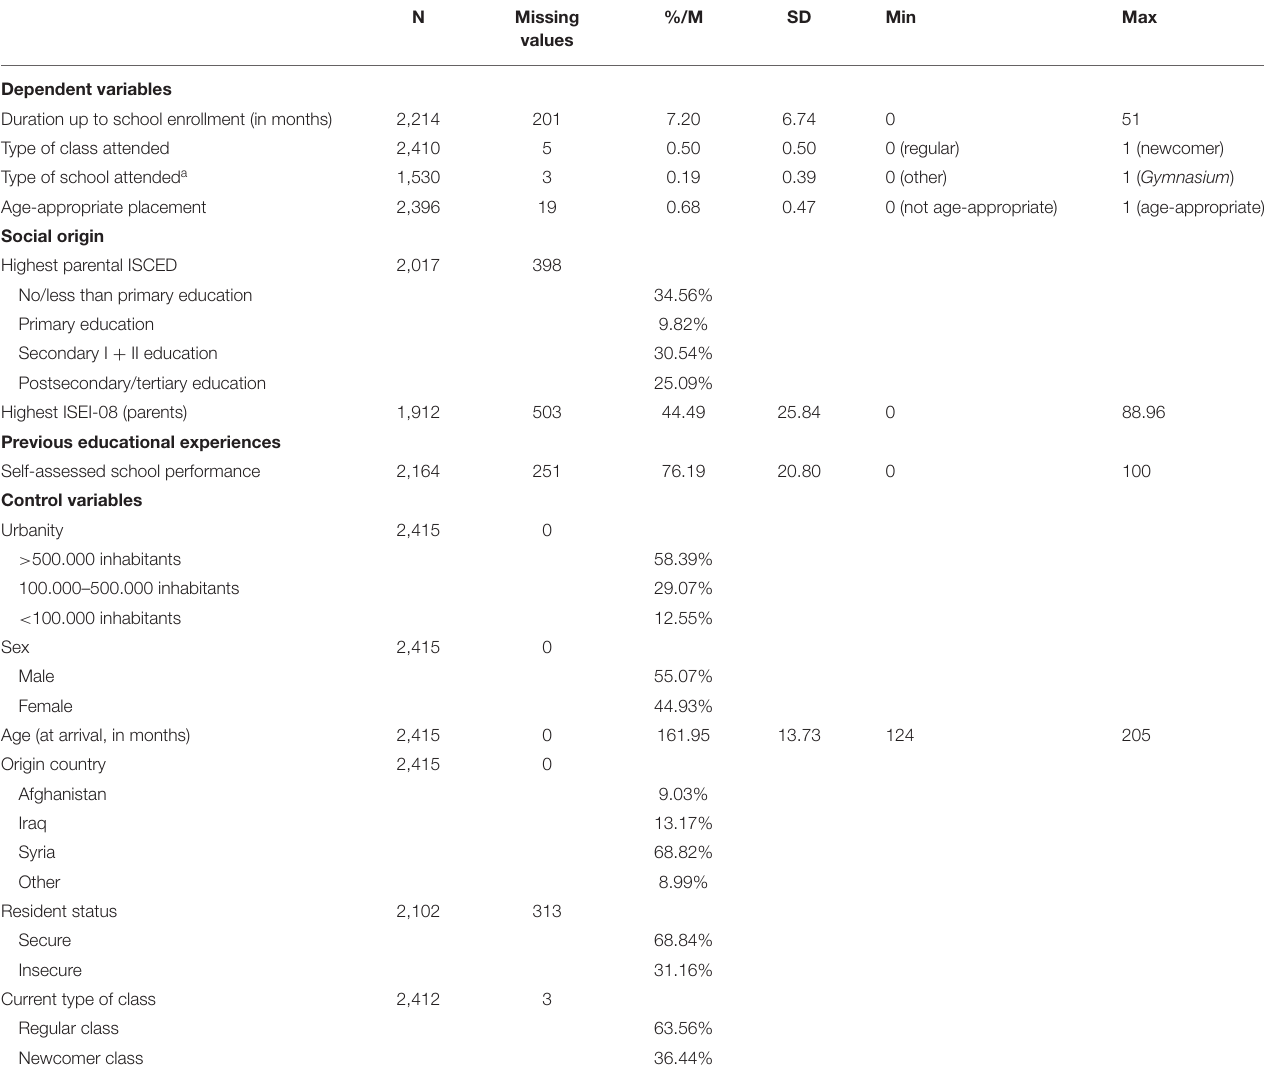
TABLE 4 | Overview of dependent and control variables.